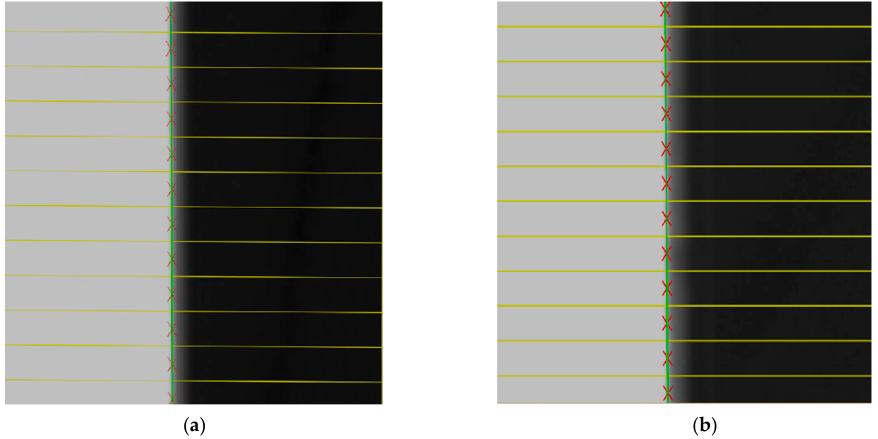
Figure 13. The fitting line of subpixel coordinates of the images captured by camera. ( a ) The image captured by the left camera. ( b ) The image captured by the right camera.